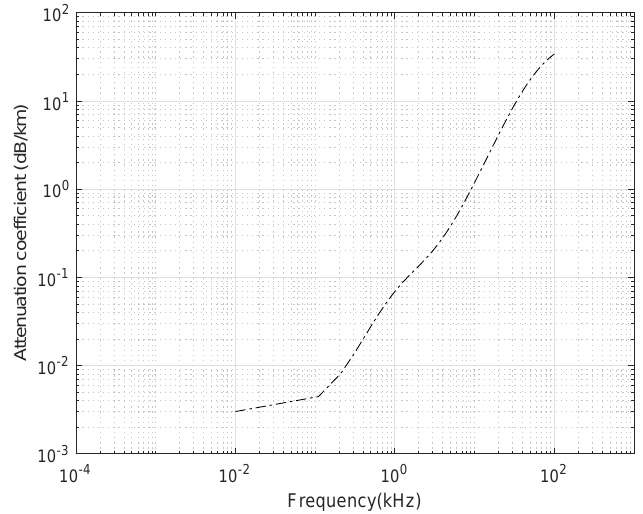
Figure 2. Attenuation coefficient in